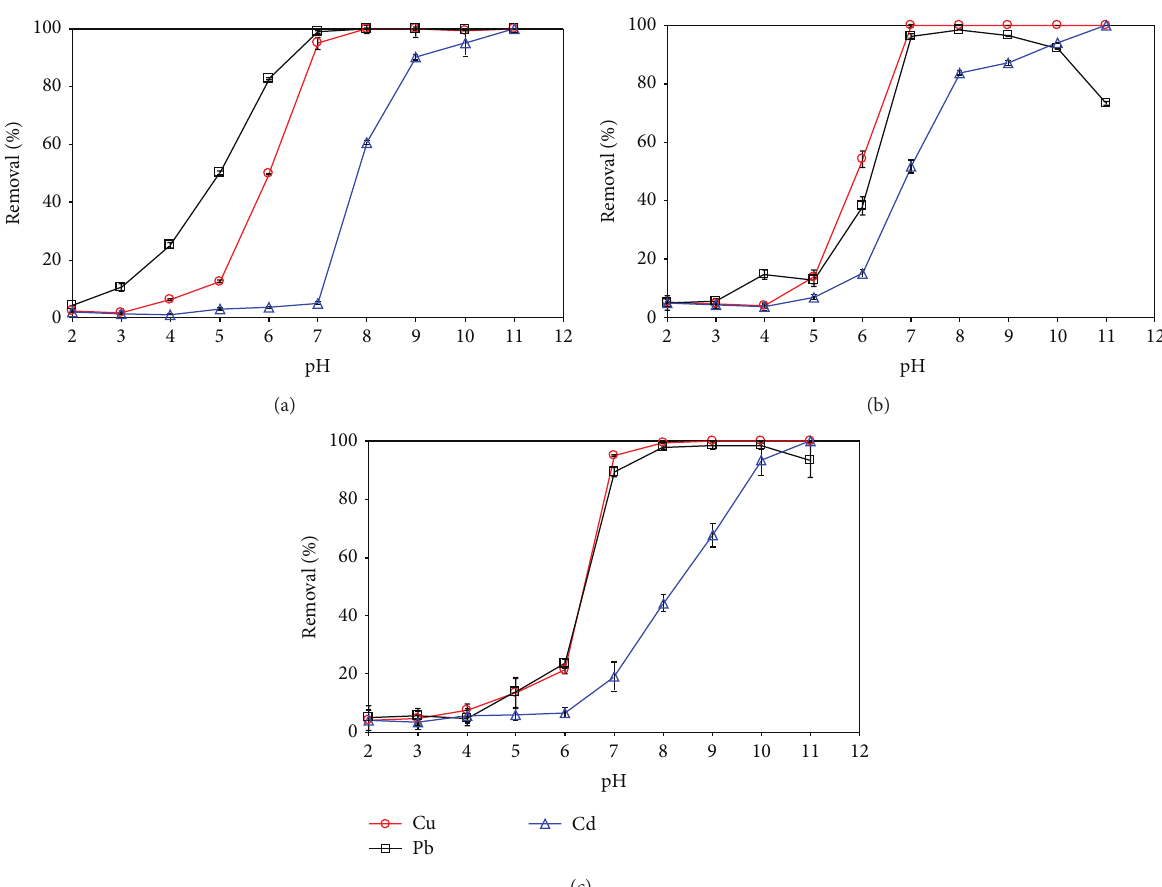
Figure 3: Effects of solution pH on the percent removals of three metals by adsorption upon magnetic GO (a), MWCNT (b), and PAC